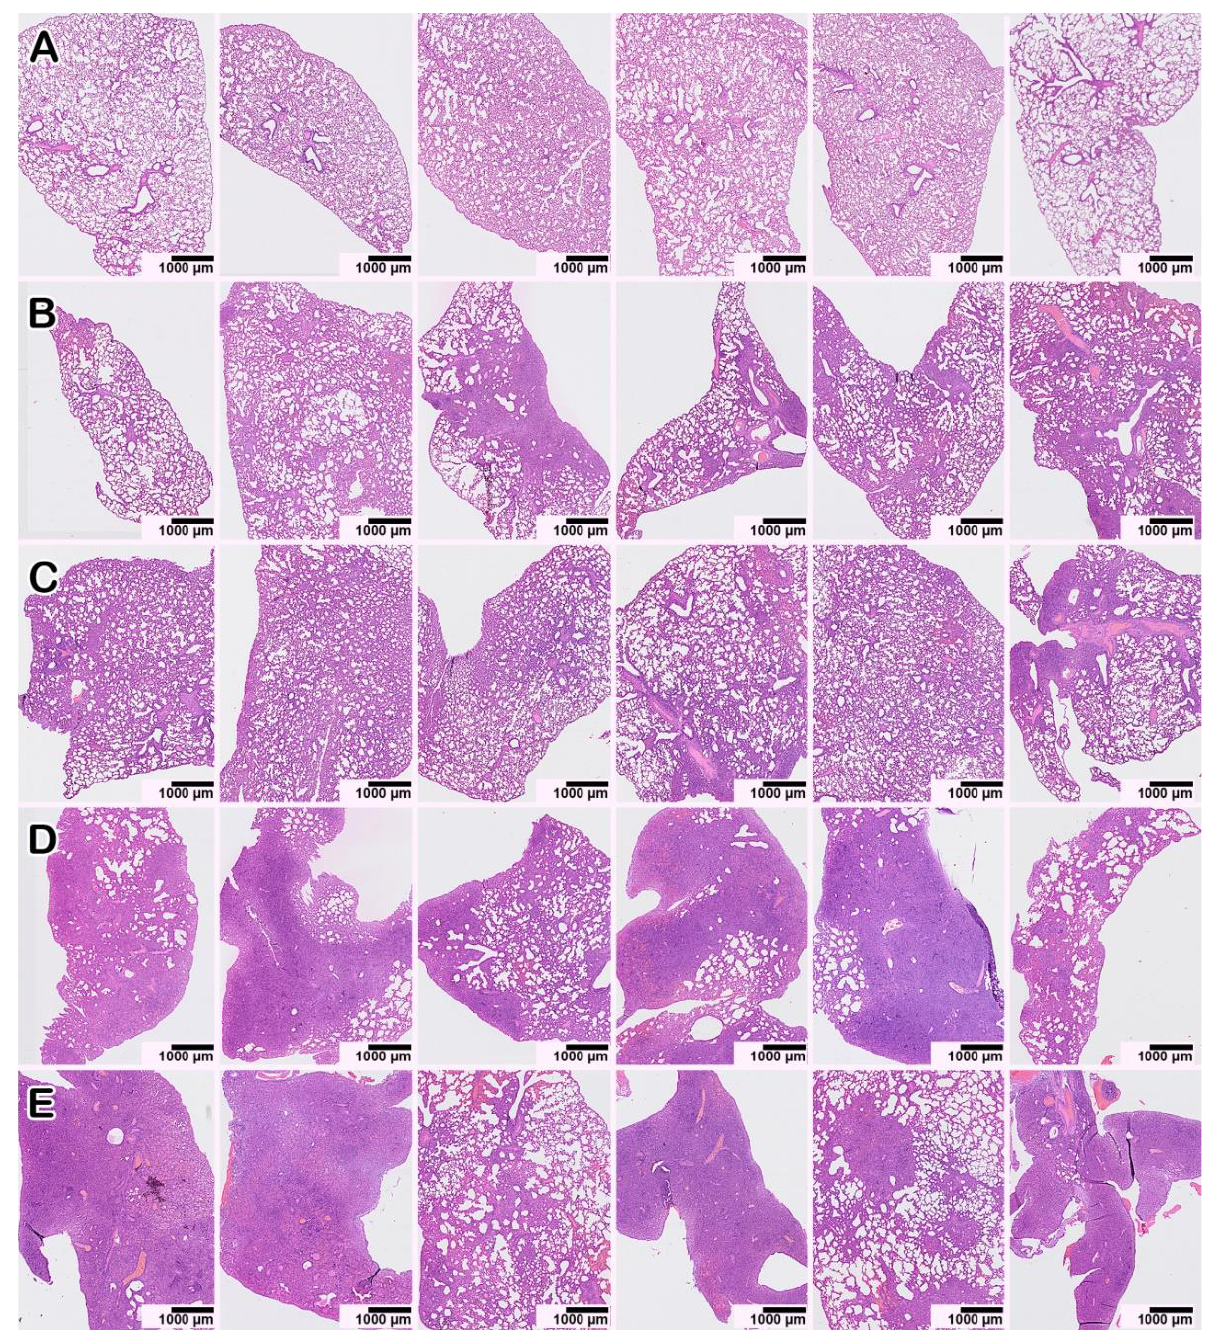
Figure 6. Pathological lesions in hamster lungs 10 days after monoinfection with IAV ( B , C ) or on Day 10 after infection with IAV and Day 6 after infection with SARS-CoV-2 for the case of coinfection ( D , E ). Each of the six survey images shows the lung tissue of one animal (the three on the left — the left lung; the three on the right — the right lung) to give a representative idea of the nature and prevalence of the pathology. ( A ) Mock-infected animal. ( D , E ) In double-infected animals, zones of dense consolidation of lung tissue caused by edema and cellular infiltration, mainly lymphocytic, spread to the entire anatomical lobe. Staining with hematoxylin–eosin. All images were taken using a 20 × objective and are presented at the same scale. The scale bar is shown in the